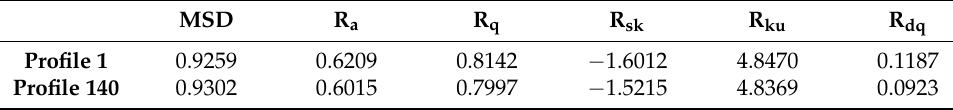
Figure 15. Two profiles from the same sample. Table 9. Geometrical texture indicators.